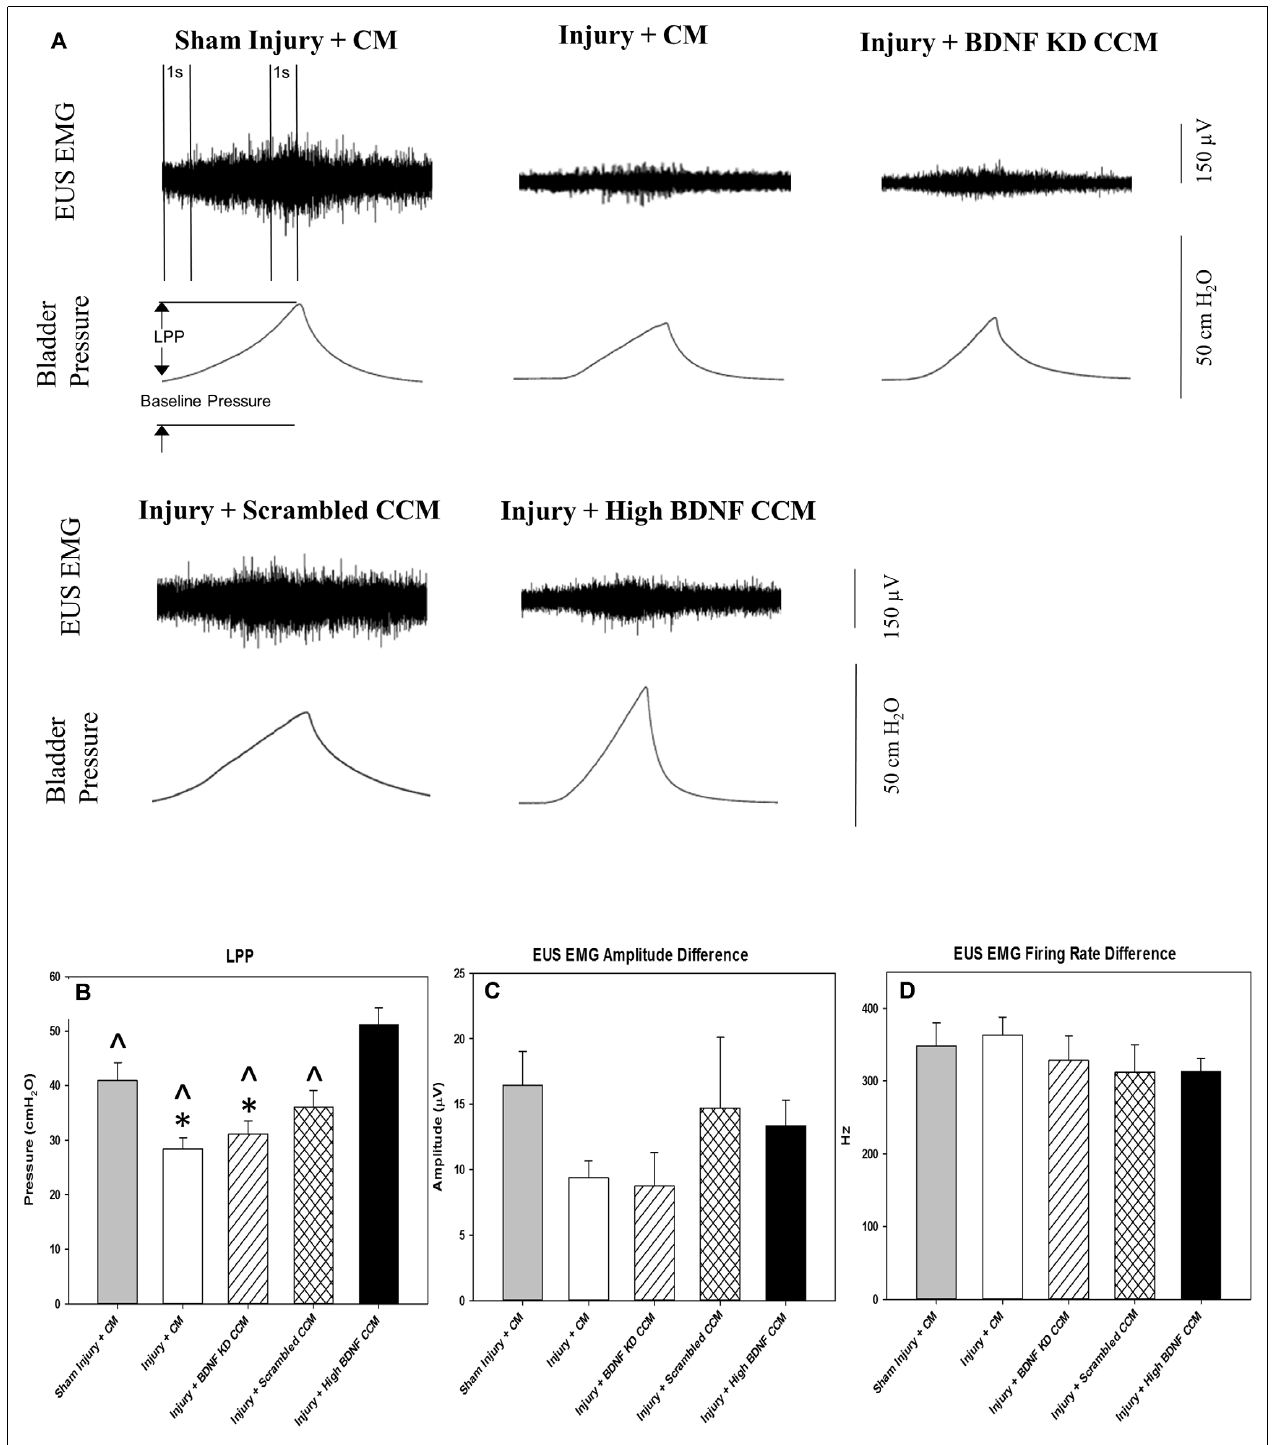
FIGURE 3 | Leak Point Pressure (LPP) and External Urethral Sphincter (EUS) Electromyograph (EMG). Example of LPP and EUS EMG data for Sham Injury + Control Media (CM), Injury (Pudendal Nerve Crush + Vaginal Distension) + CM, Injury + Brain-Derived Neurotrophic Factor Knockdown (BDNF KD) Concentrated Conditioned Media (CCM), Injury + Scrambled CCM, or Injury + High BDNF CCM (A) . The vertical dashed lines show where 1-s EUS EMG segments were selected at baseline and peak pressure for analysis. Functional results from urinary function testing: LPP (B) , EUS EMG Amplitude (C) , and Firing Rate (D) . Each bar represents the mean ± standard error of the mean of 12 animals per group. ANOVA followed by a Student-Newman-Keuls post-hoc test was used to indicate significant differences. ∗ Indicates a statistically significant difference compared to Sham Injury + CM; ∧ indicates a statistically significant difference compared to Injury + High BDNF